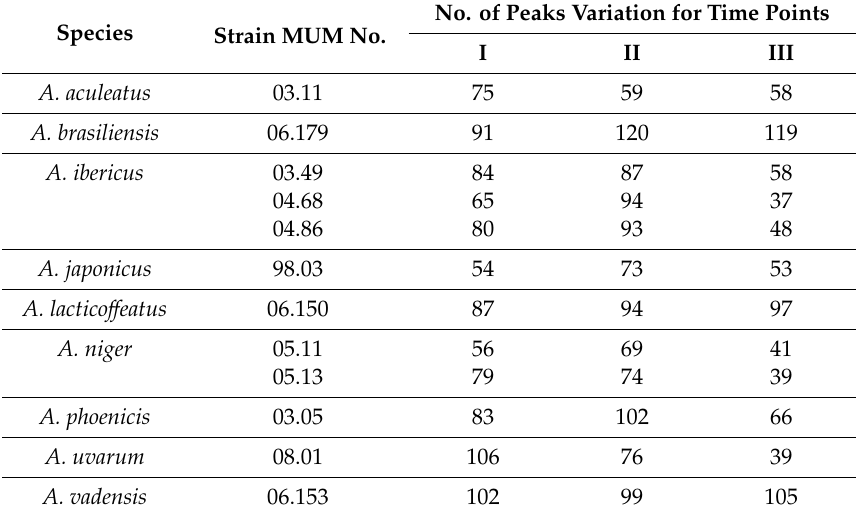
Table 6. Variation in the number of spectral data peaks for time points II and III in comparison with time point I for 12 Aspergillus strains. No. of Peaks Variation for Time Points Species Strain MUM No. I II